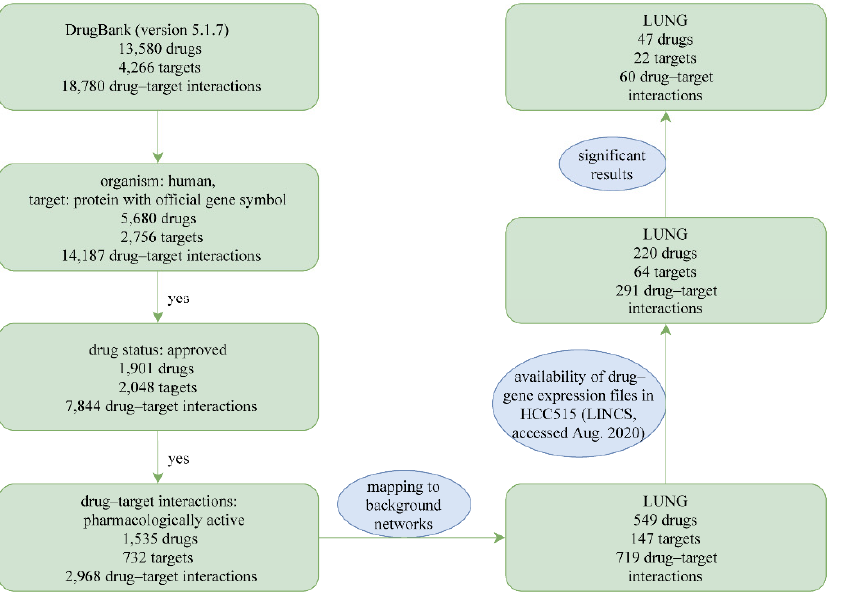
Figure 2. Overview of drug filtration. Drugs available in DrugBank (version 5.1.7) were selected according to the following steps: (1) drugs having humans as the organism, (2) drugs must be approved, (3) drug targets with a pharmacologically active status, (4) the genes for the drug targets could be mapped to the lung-specific background network, (5) the drug gene expression profiles in HCC515 (cell line) of these drugs could be retrieved from LINCS, and (6) identified drugs that have a significant proximity score (see Section 2.8).